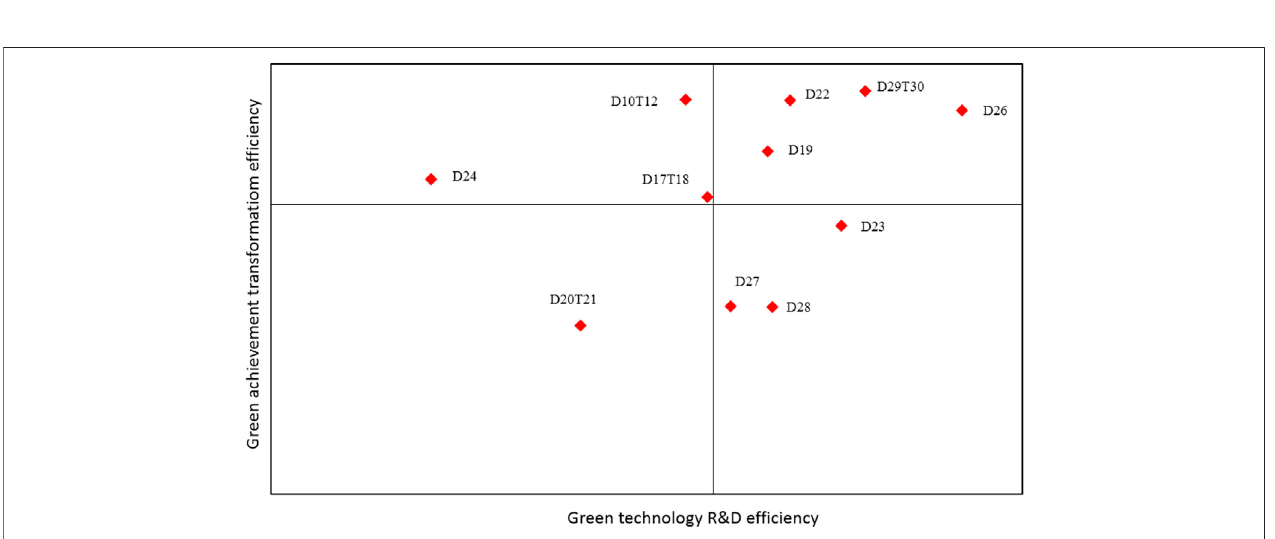
FIGURE 3 | Matrix diagram of two-stage GIVC mean ef fi ciency.